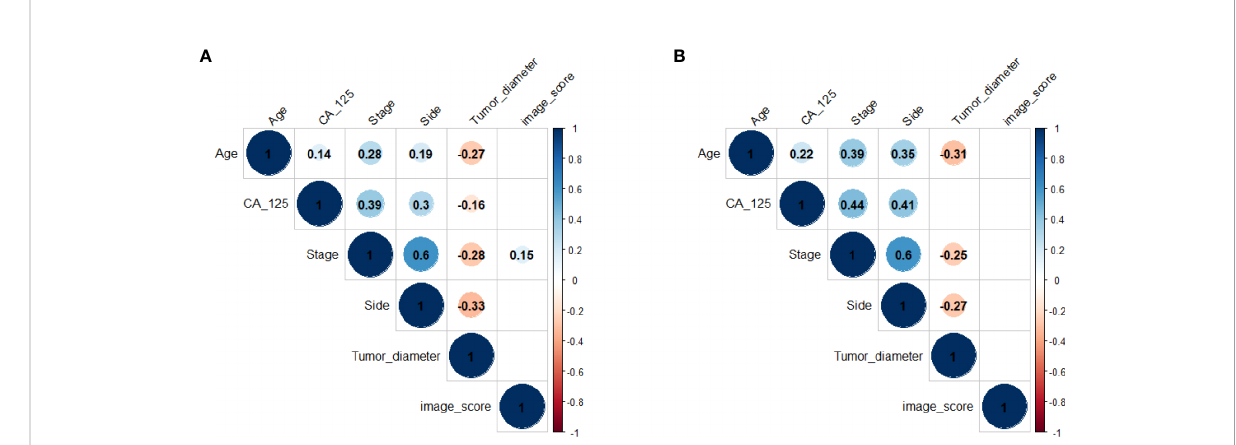
FIGURE 2 Correlation matrix of clinical characteristics and the image score in training cohort (A) and validation cohort (B) . Values in this fi gure indicated the correlation coef fi cient of two corresponding variables. The colour and the size of the circles represent the strength of the correlation. Lack of color means no